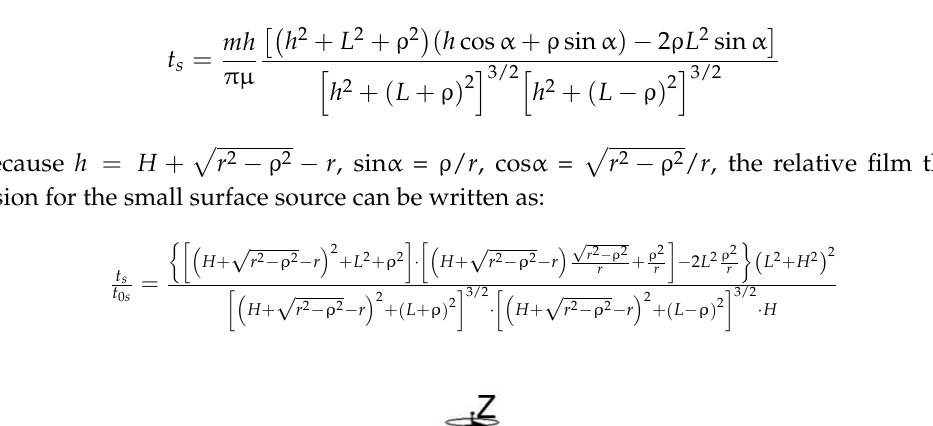
Figure 11. Distribution of the thin film thickness on the rotating planar plate substrate holder.